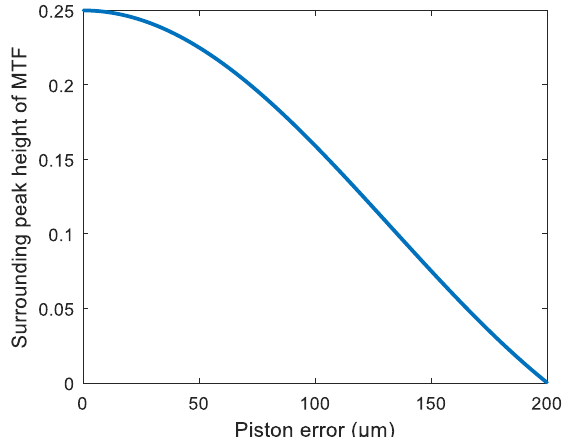
Figure 11. Peak heights of the MTF sidelobes varying with the piston errors of the optics system composed of 4 sub-mirrors.